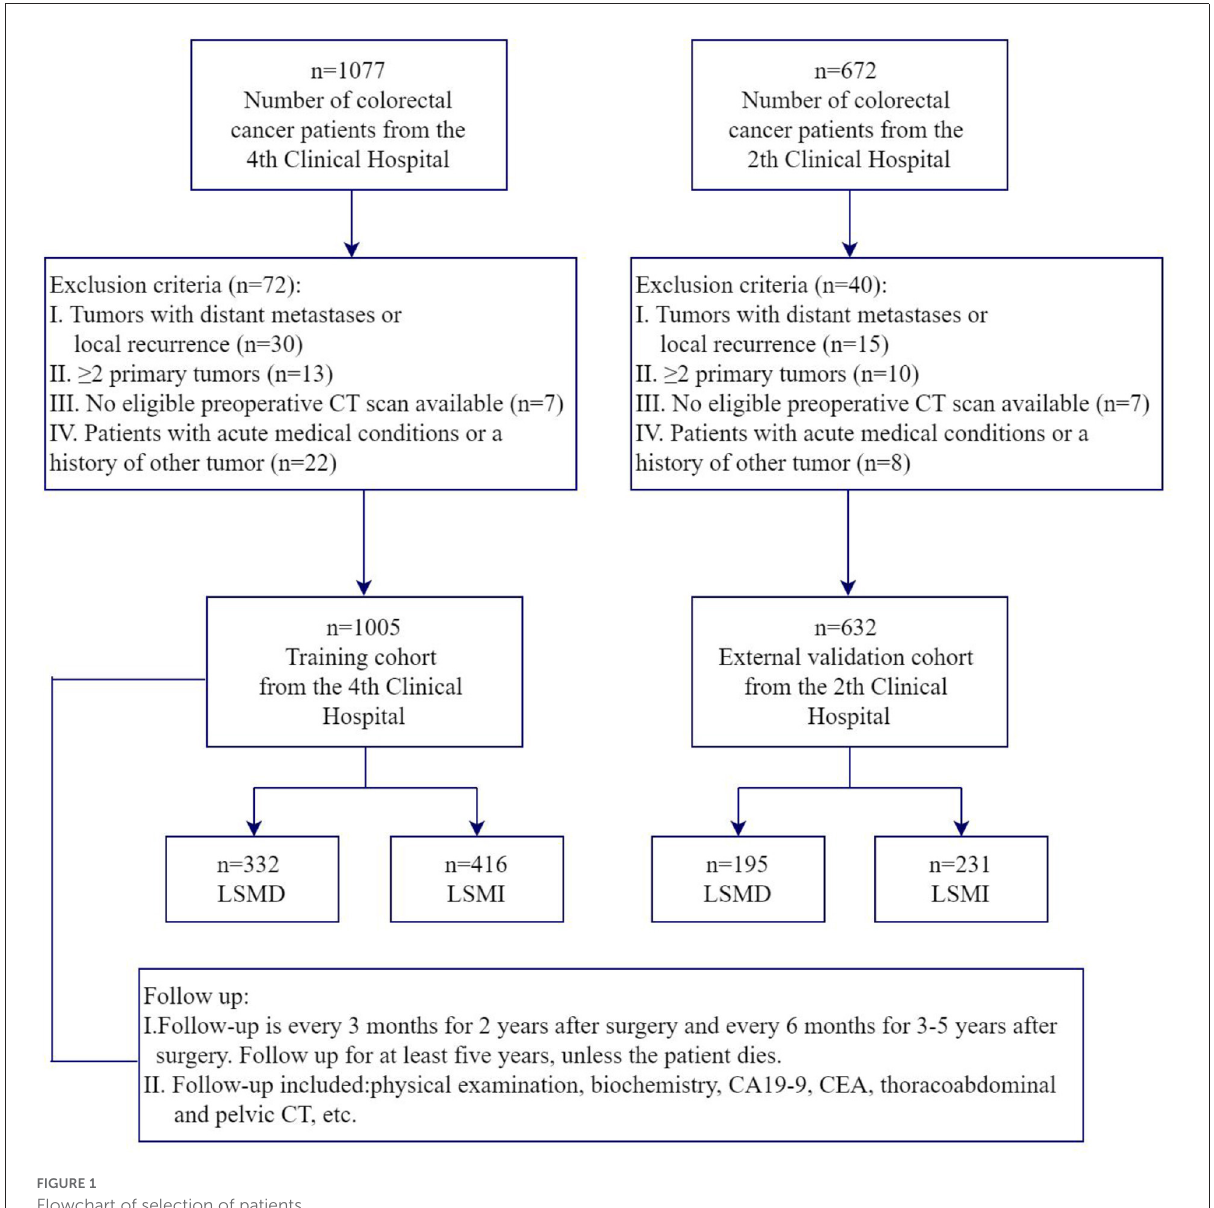
FIGURE1 Flowchart of selection of patients.